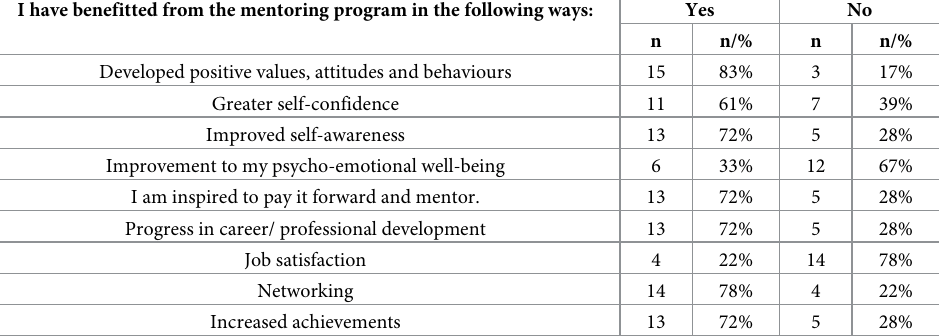
Table 10. Benefits of mentoring